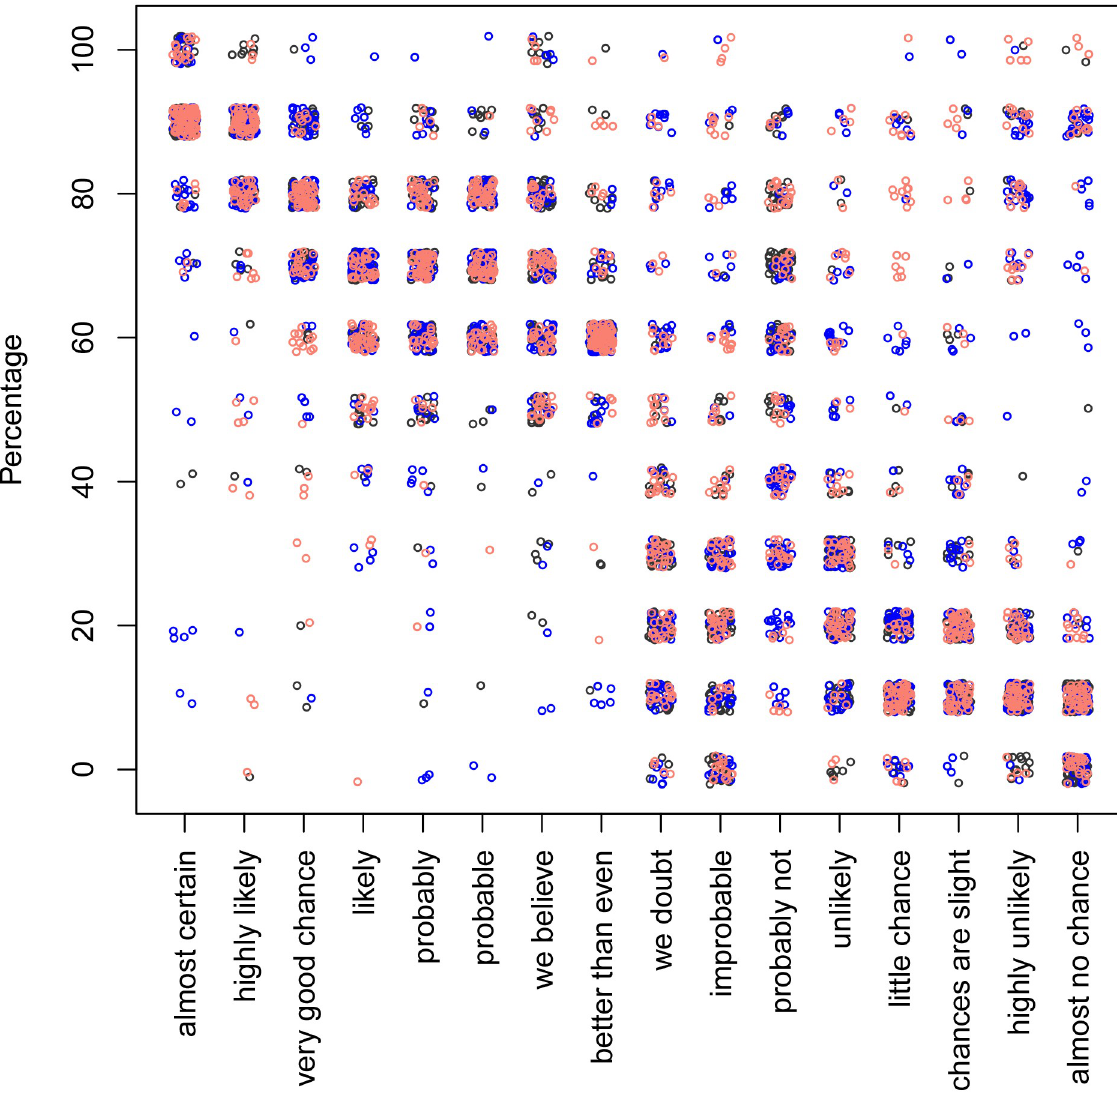
Fig 4. The percentages associated with the phrases, using the “uncertainty” prompt. The black, blue, and red colours correspond to the context-free, user and car contexts, respectively. Each dot represents one response.